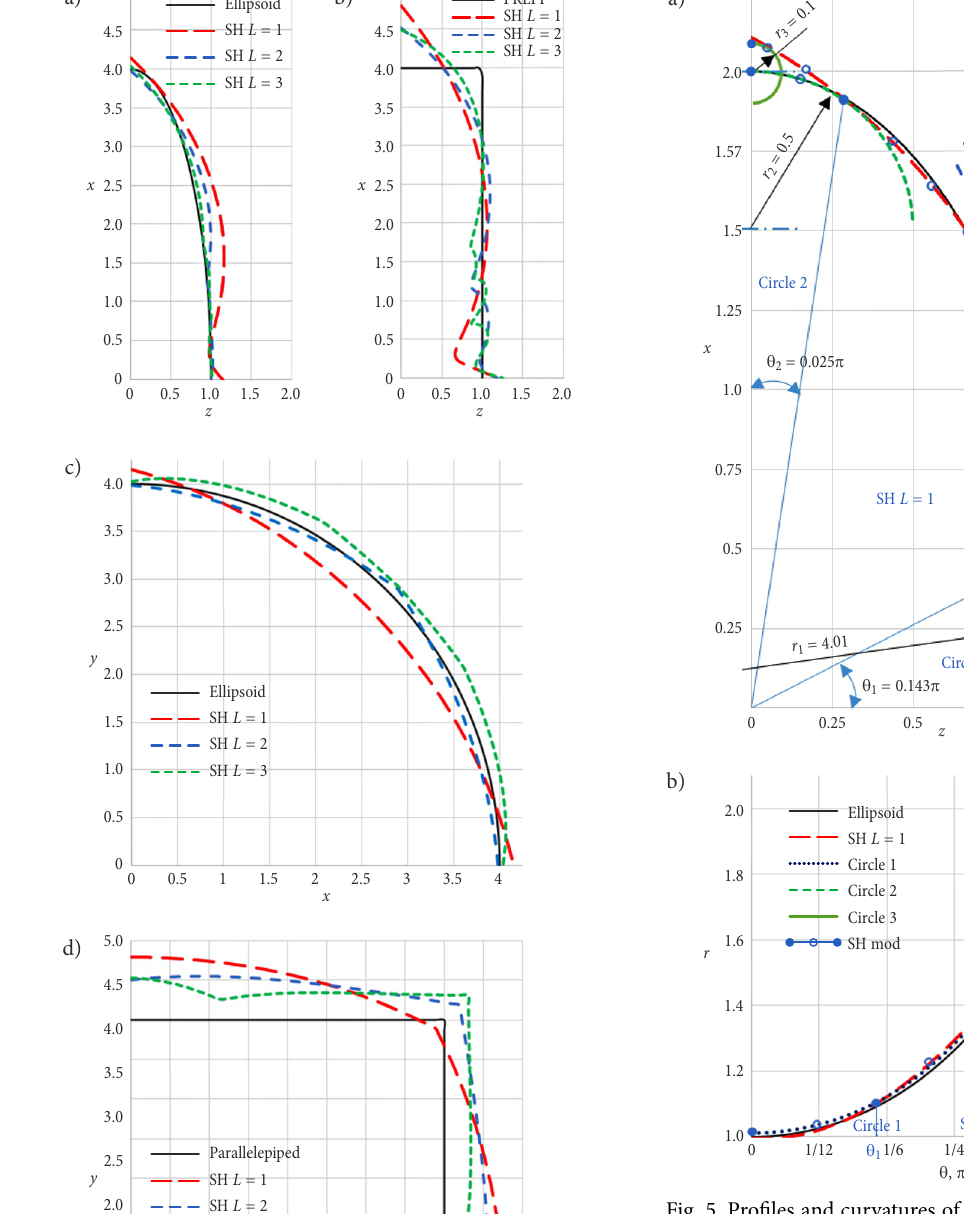
Fig. 5. Profiles and curvatures of quasi-quadric surfaces (quasi-ellipsoids): a) in Cartesian coordinates, b) in spherical